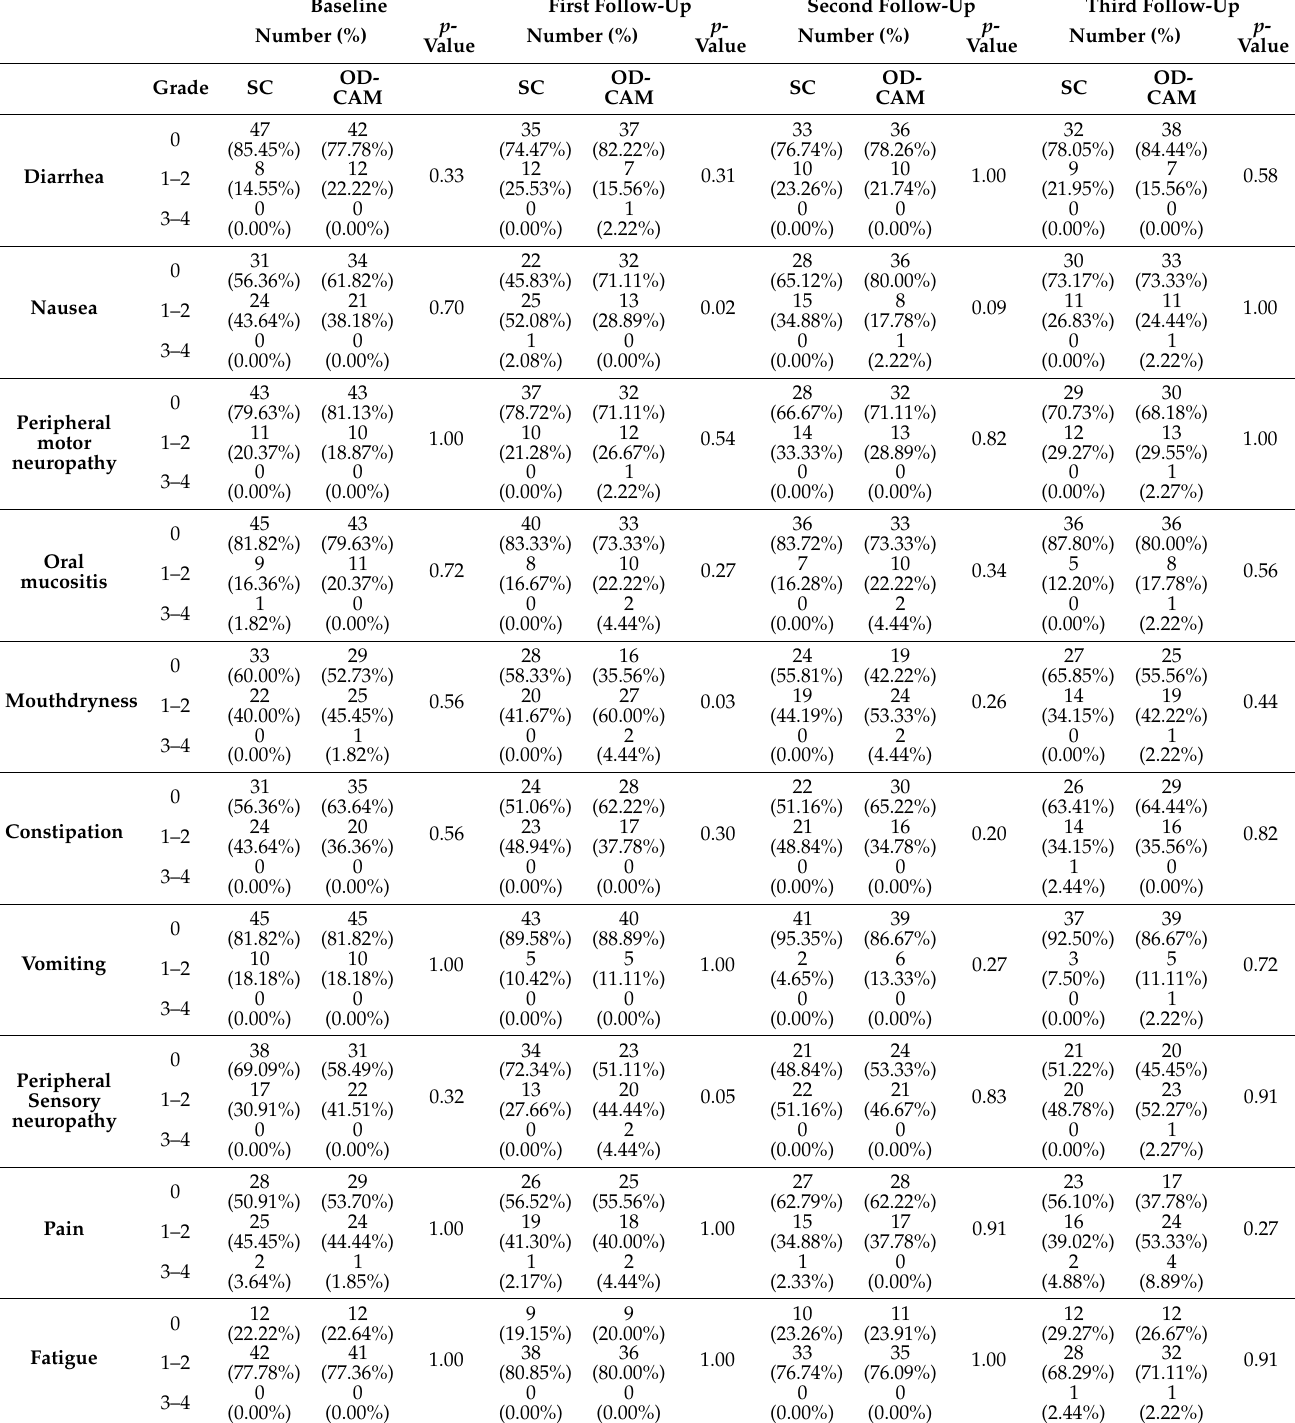
Table 3. Frequency of Adverse